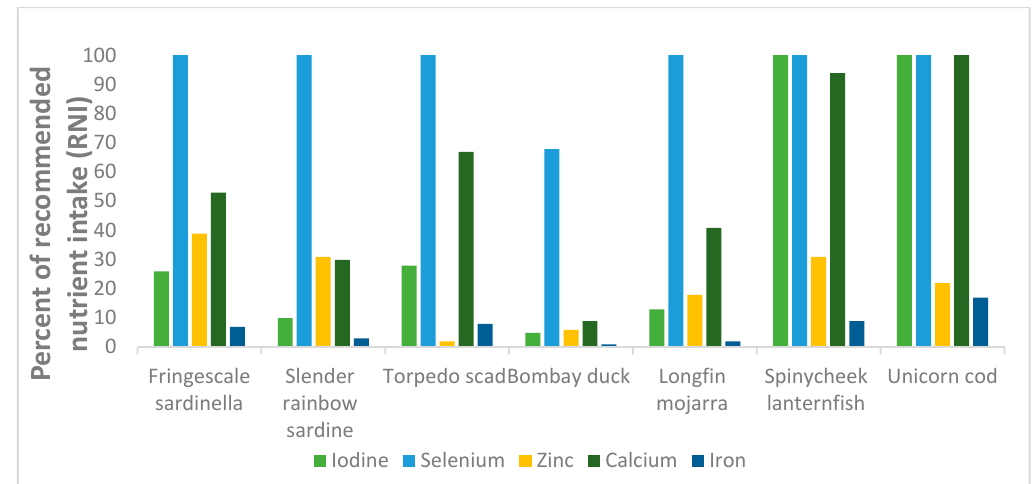
Figure 3. Percentage of recommended nutrient intake (RNI) for women of selected minerals and trace element for 100 g raw, edible parts of Fringescale sardinella (fillet), Slender rainbow sardine (fillet), Torpedo scad (fillet), Bombay duck (fillet), Longfin mojarra (fillet), Spinycheek lanternfish (whole fish), and Unicorn cod (whole